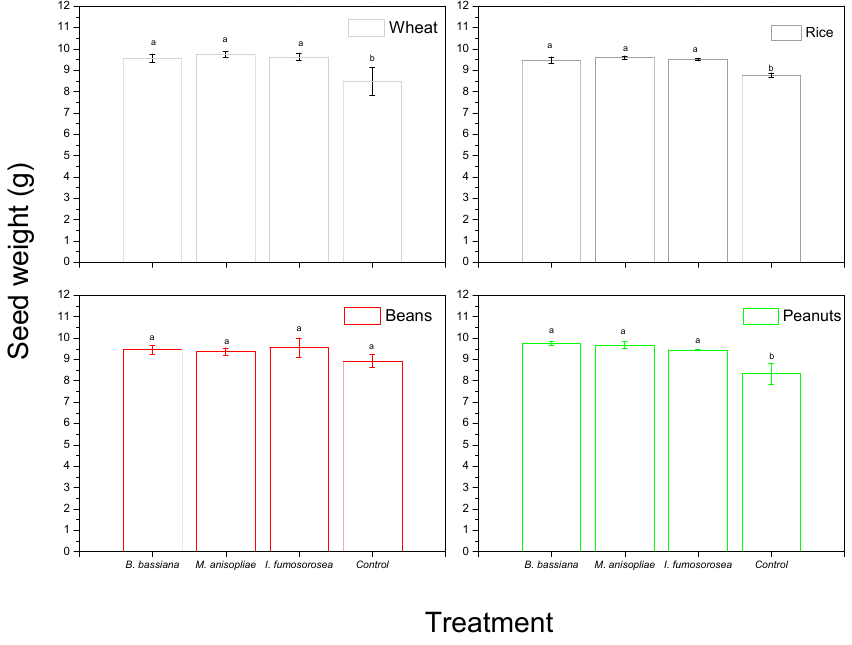
Figure 2. Seed weight (g ± SD) of wheat, rice, beans and peanuts treated with 10 8 spores mL − 1 of B. bassiana (strain name: GBBSTTS), I. fumosorosea (strain name: RHZ4RAS) and M. anisopliae (strain name: Z3RAS) after infestation with T. granarium larvae for 10 days.